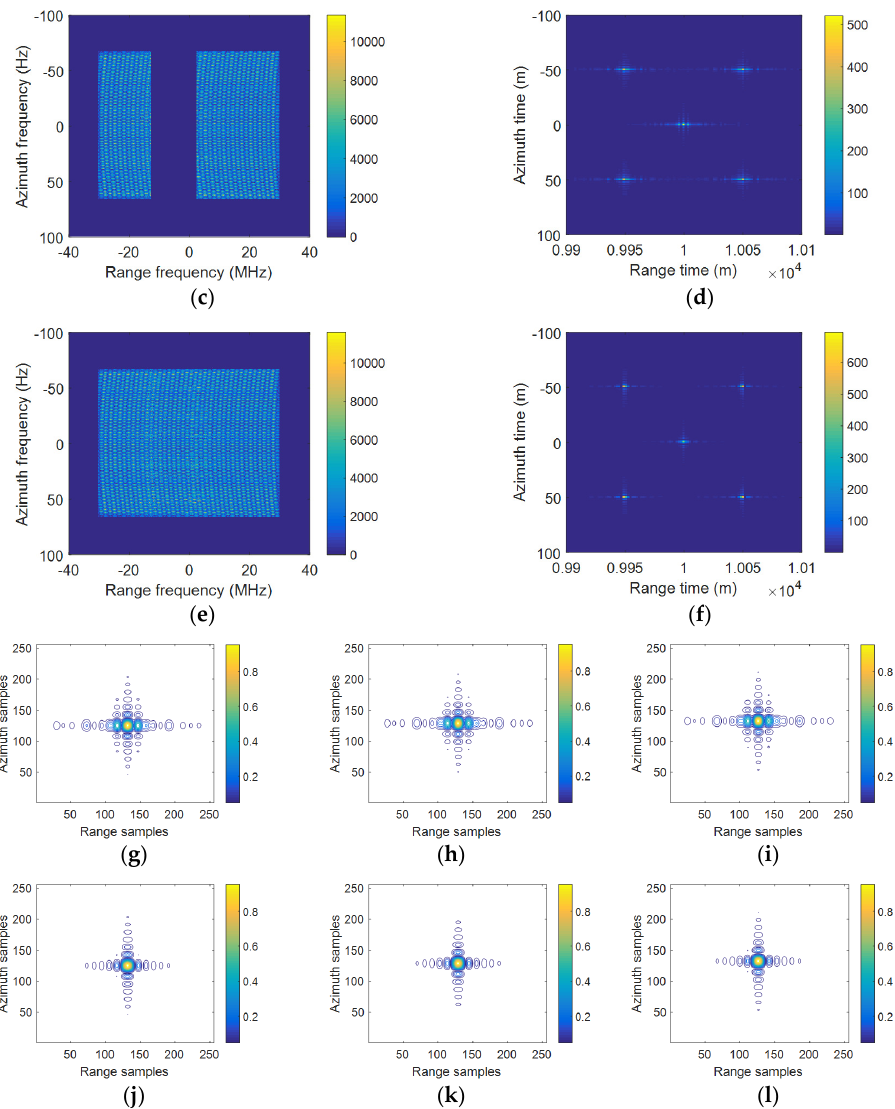
Figure 11. 2D simulation results on point targets. ( a ) The interfered 2D spectrum; ( b ) the imaging result with RFI; ( c ) the 2D spectrum after band-filtering; ( d ) the imaging result of ( d ); ( e ) the reconstructed spectrum; ( f ) the imaging result after the RSIAA; ( g )-( i ) contour plots of Point 1, 3 and 5 in ( c ); ( j )-( l ) contour plots of Point 1, 3 and 5 in ( f ).